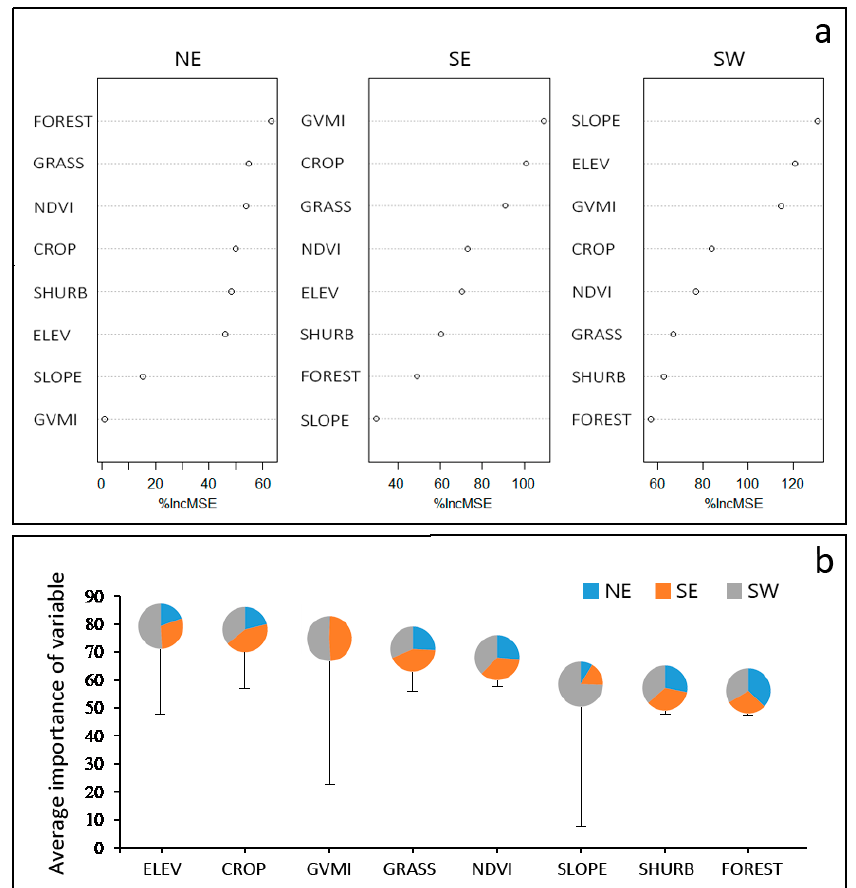
Figure 3. Variable importance measures (%IncMSE- Increase in Mean Square Error) of landscape factors from Random Forests in different regions ( a ). Comparison of the relative importance of variables to fire occurrence (pie charts) and the relative importance of each variable among three regions (different portions within each pie chart) ( b ). The bars below each pie chart represent the standard deviation of the relative importance of each variable amongst the three forest ecosystems. %IncMSE ( x -axis) quantifies the importance of a variable by measuring the change in prediction accuracy when the values of the variable are randomly permuted compared with the original observations. Abbreviated variable names are described in Table 2.